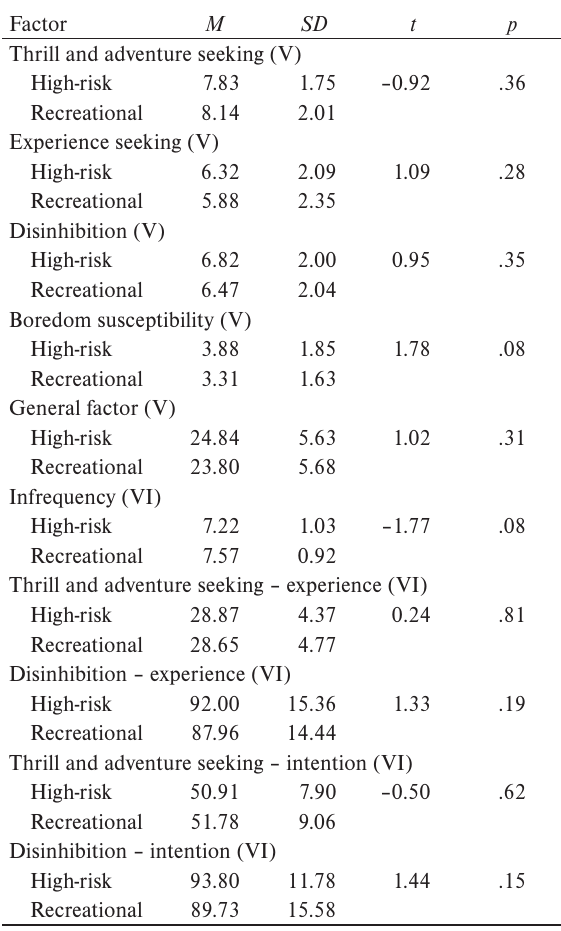
Differences between high-risk sports athletes and